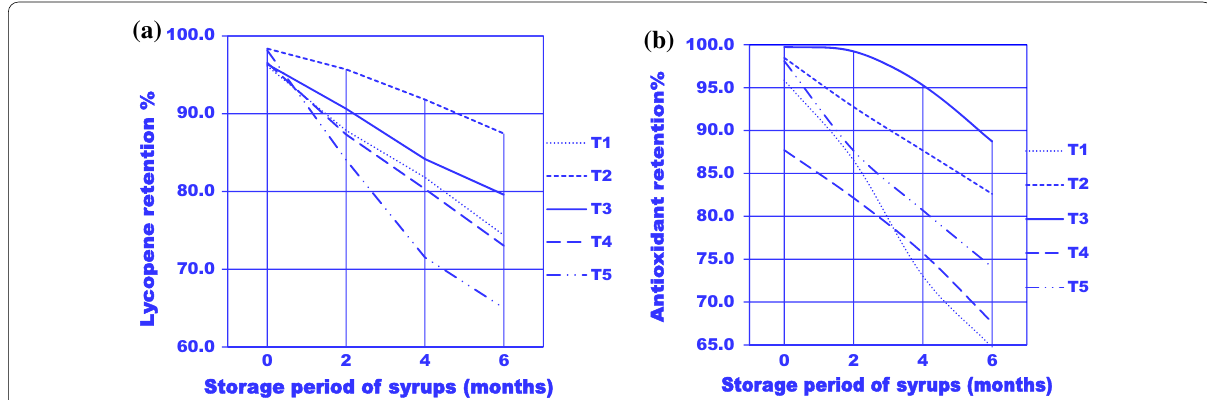
Fig. 4 Retention of lycopene and antioxidants activity in different syrups during the storage